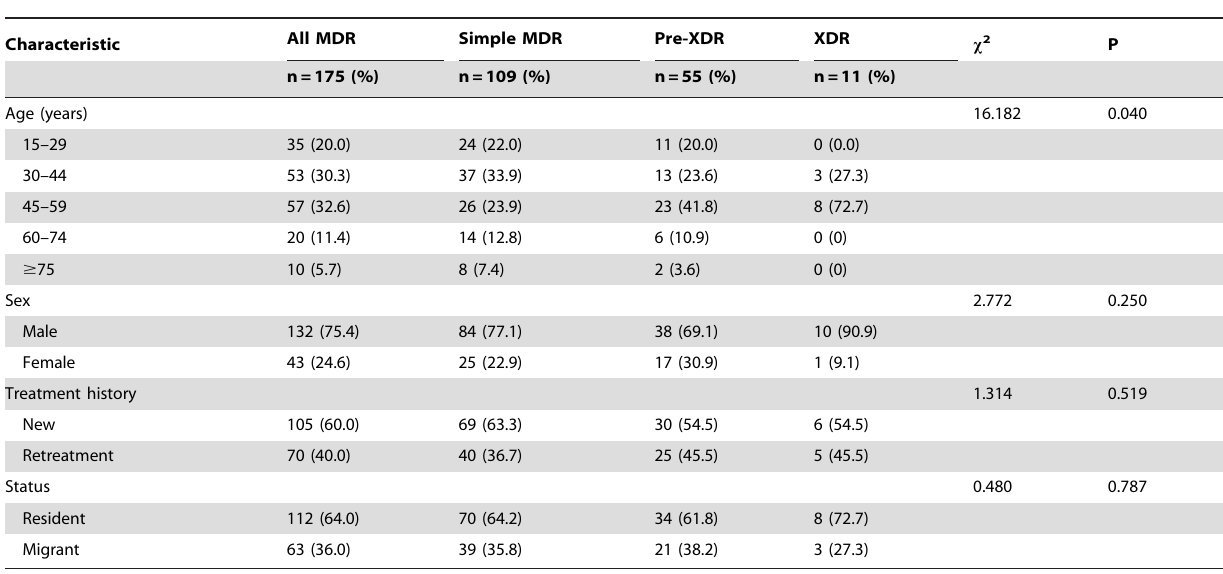
Table 1. Characteristics of tuberculosis patients by drug resistance group, Shanghai, March 2004–November